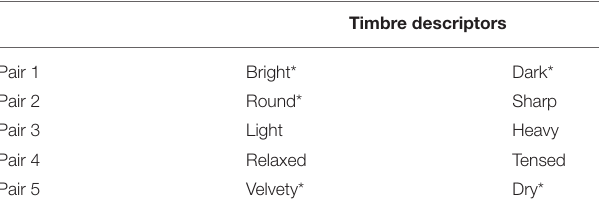
TABLE 1 | Ten timbre descriptors used in the perceptual experiment.